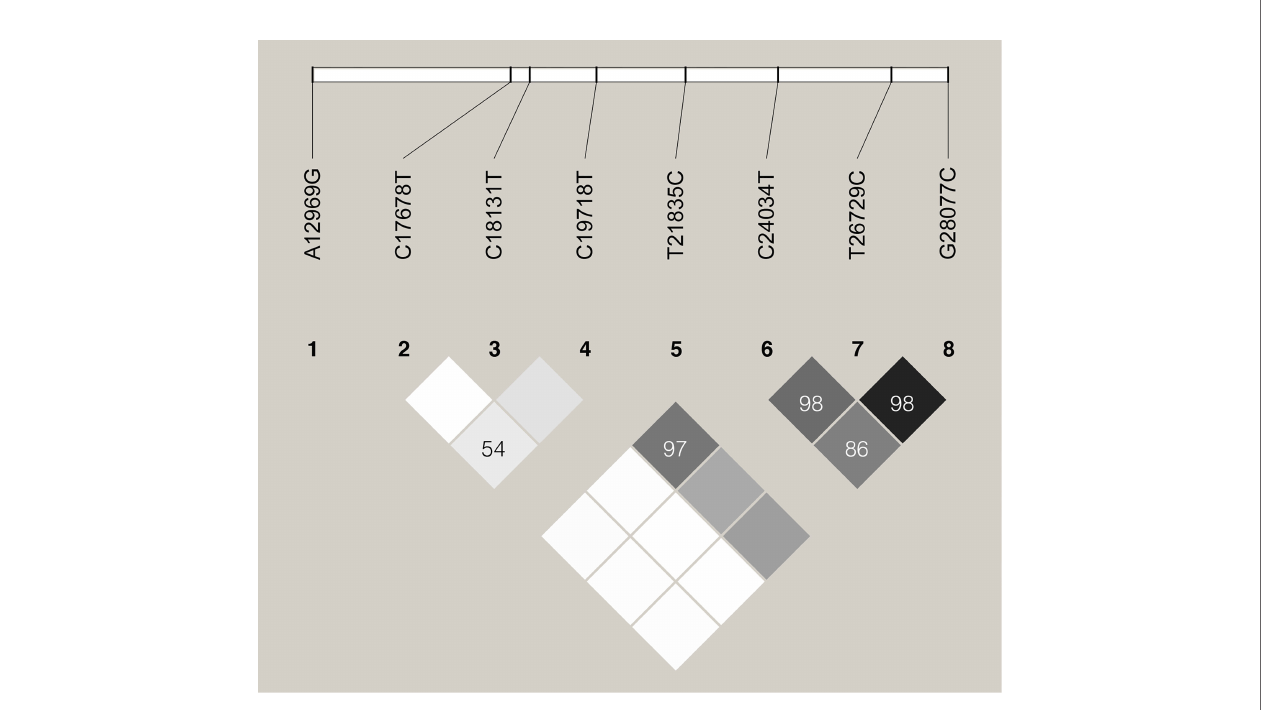
FIGURE 4 | Linkage disequilibrium plot of haplotypes of the 8 speci fi c sites. D ’ values are indicated in percentages within squares.